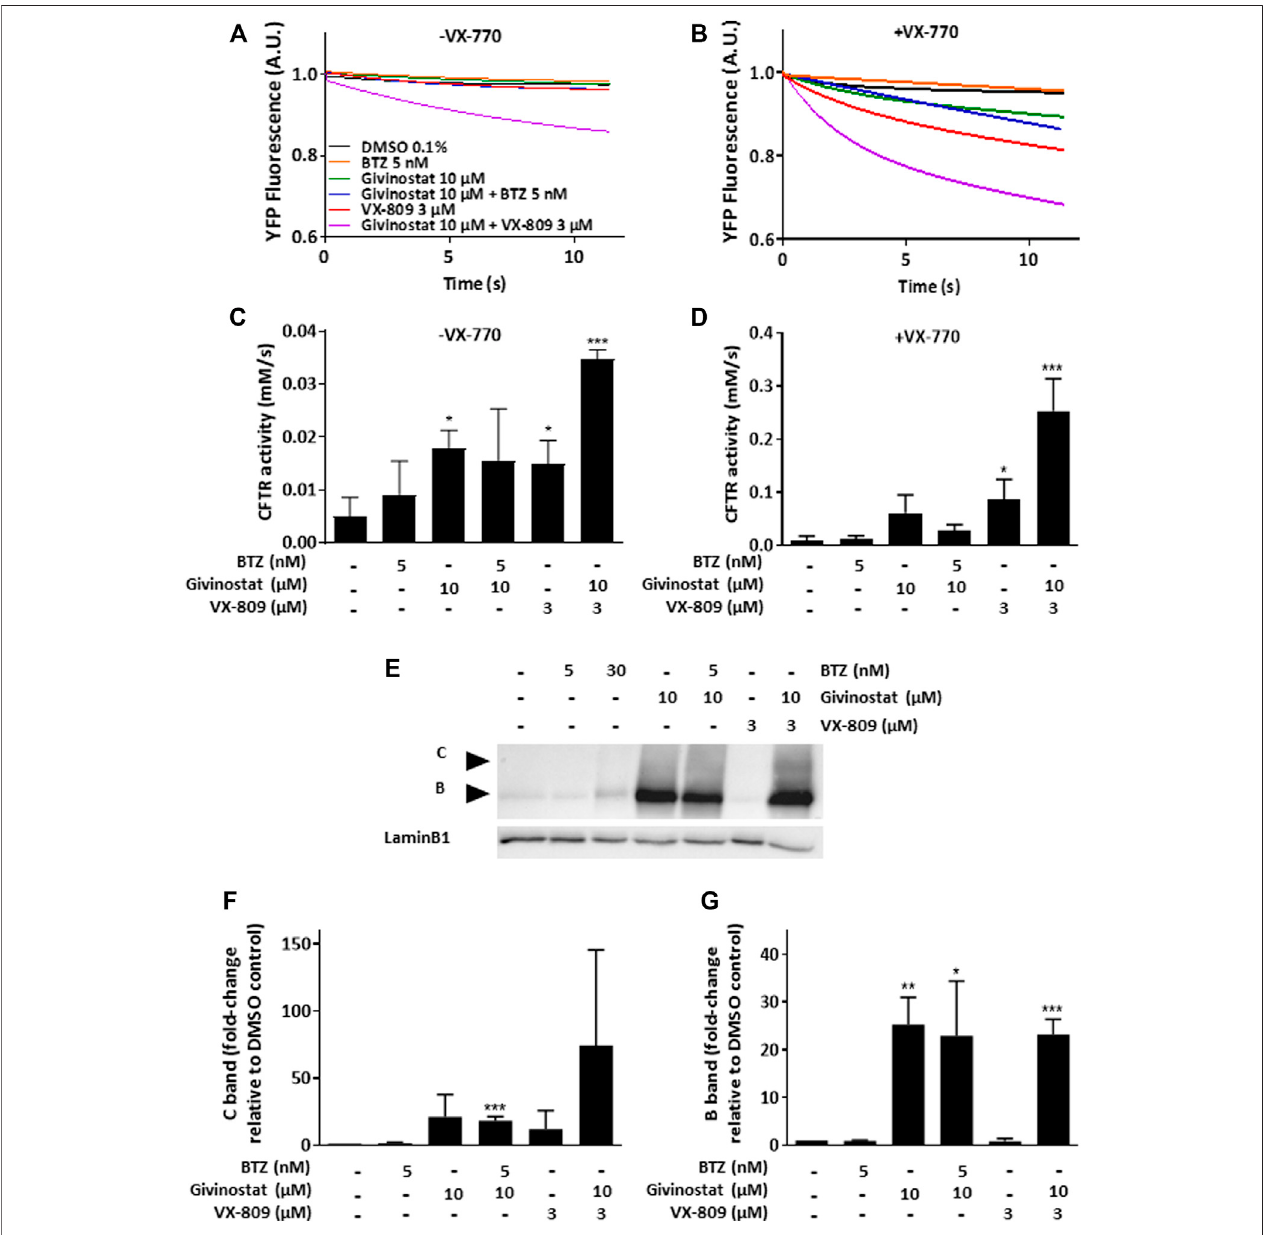
FIGURE4| EvaluationofgivinostatonCFTRactivity. (A – D) MeasureofYFP fl uorescence (A,B) andquanti fi cationofCFTRactivity (C,D) inHEK-F508del/YFPcells treatedwithdifferentcombinationsofBTZ(5 nM),givinostat(10 μ M)orVX-809(3 µM)for24 hinabsence (A,C) orinpresence (B,D) ofVX-770(10 µM)for30 min. (E – G) Immunoblot analysis (E) and quanti fi cation of the C-band (F) or the B-band (G) of CFTR expression in CFBE-F508del cells treated with different combinations of BTZ (5 nM), givinostat (10 μ M) or VX-809 (3 μ M) for 24 h. LaminB1 was used to evaluate the loading. Values are expressed as fold-change relative to DMSO 0.1% treatment. Data are the mean ± SD of three independent experiments; * p ≤ 0.05, ** p ≤ 0.01, *** p ≤ 0.001 (Student ’ s t-test). BTZ, bortezomib.